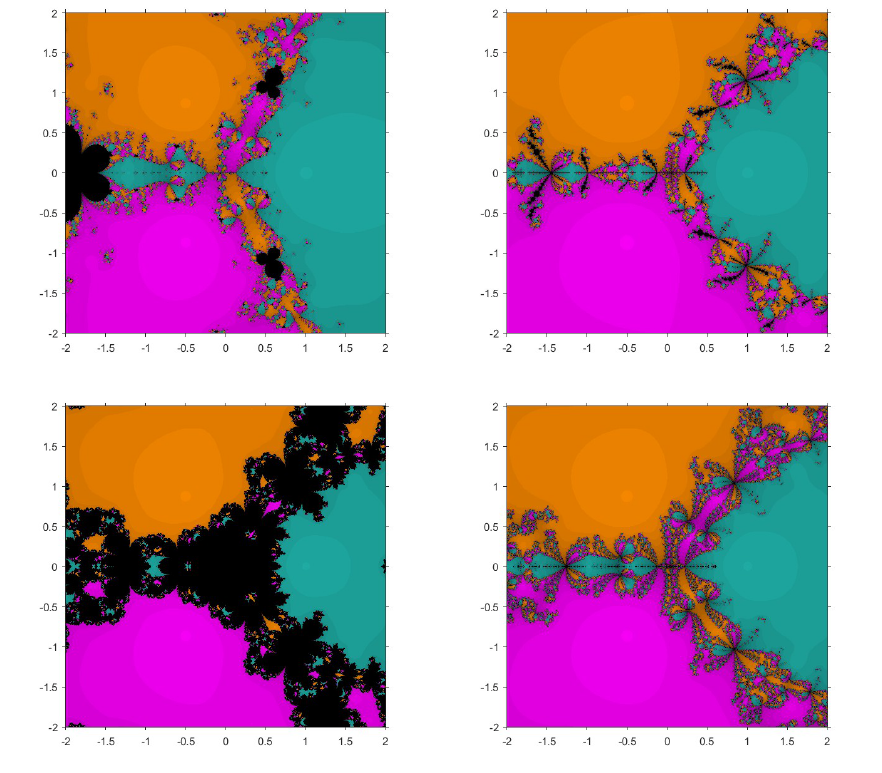
Figure 4. Basins of attraction for PMM , AM 2 , DM 1 , and DM 2 , respectively, for p 2 ( z )